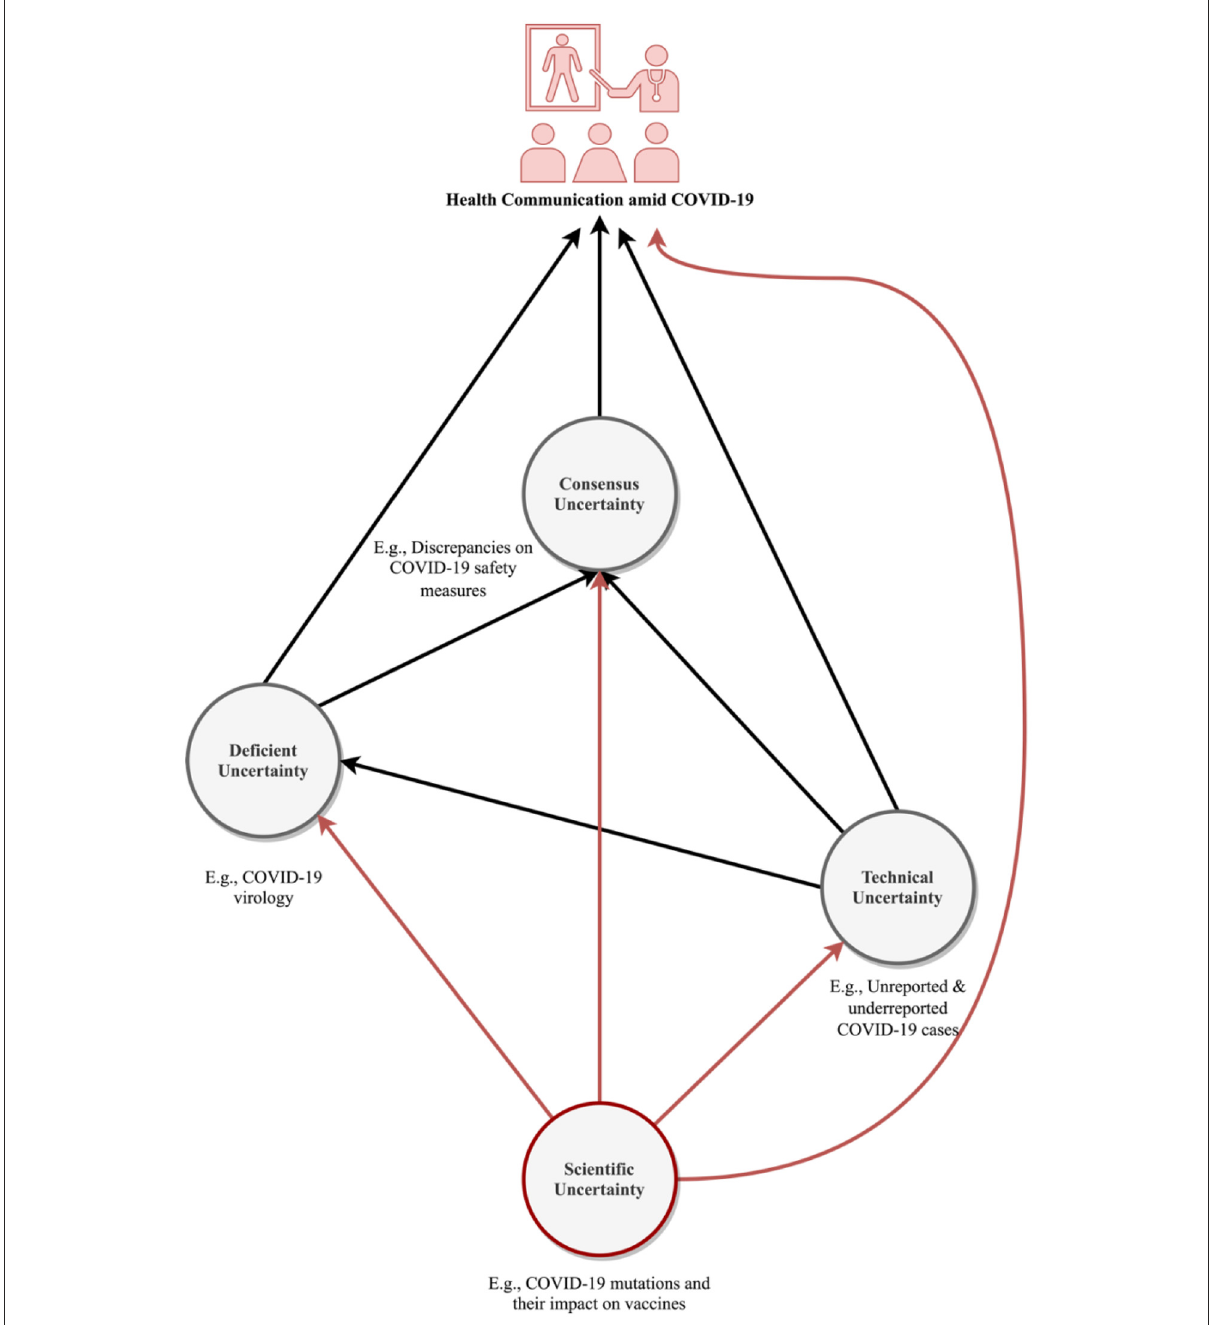
FIGURE1 A schematic representation of the interplay between COVID-19 communication and uncertainties surrounding the